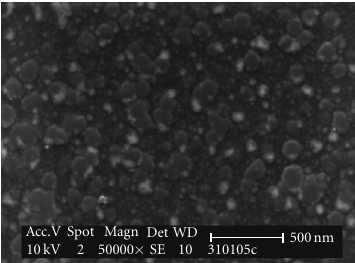
Figure 6: SEM image of an Ag sample (2 pass) after stearic acid decomposition has